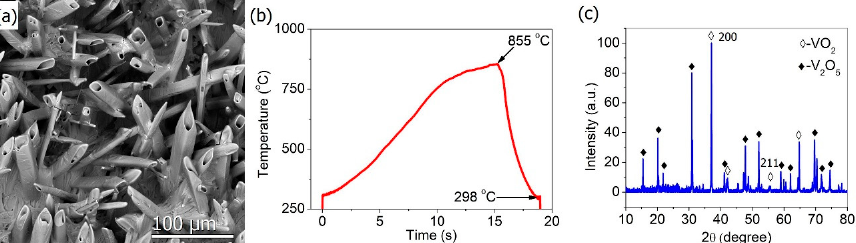
Figure 3. Characteristics of recrystallization product via heating with low peak temperature and cooling rapidly: ( a ) SEM image, ( b ) temperature vs. time curve during recrystallization, and ( c ) XRD pattern.